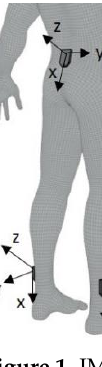
Figure 1. IMU placements on the different body locations and relative axis orientations.